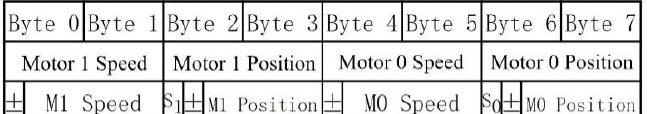
Figure 12. Servo driver data upload format.